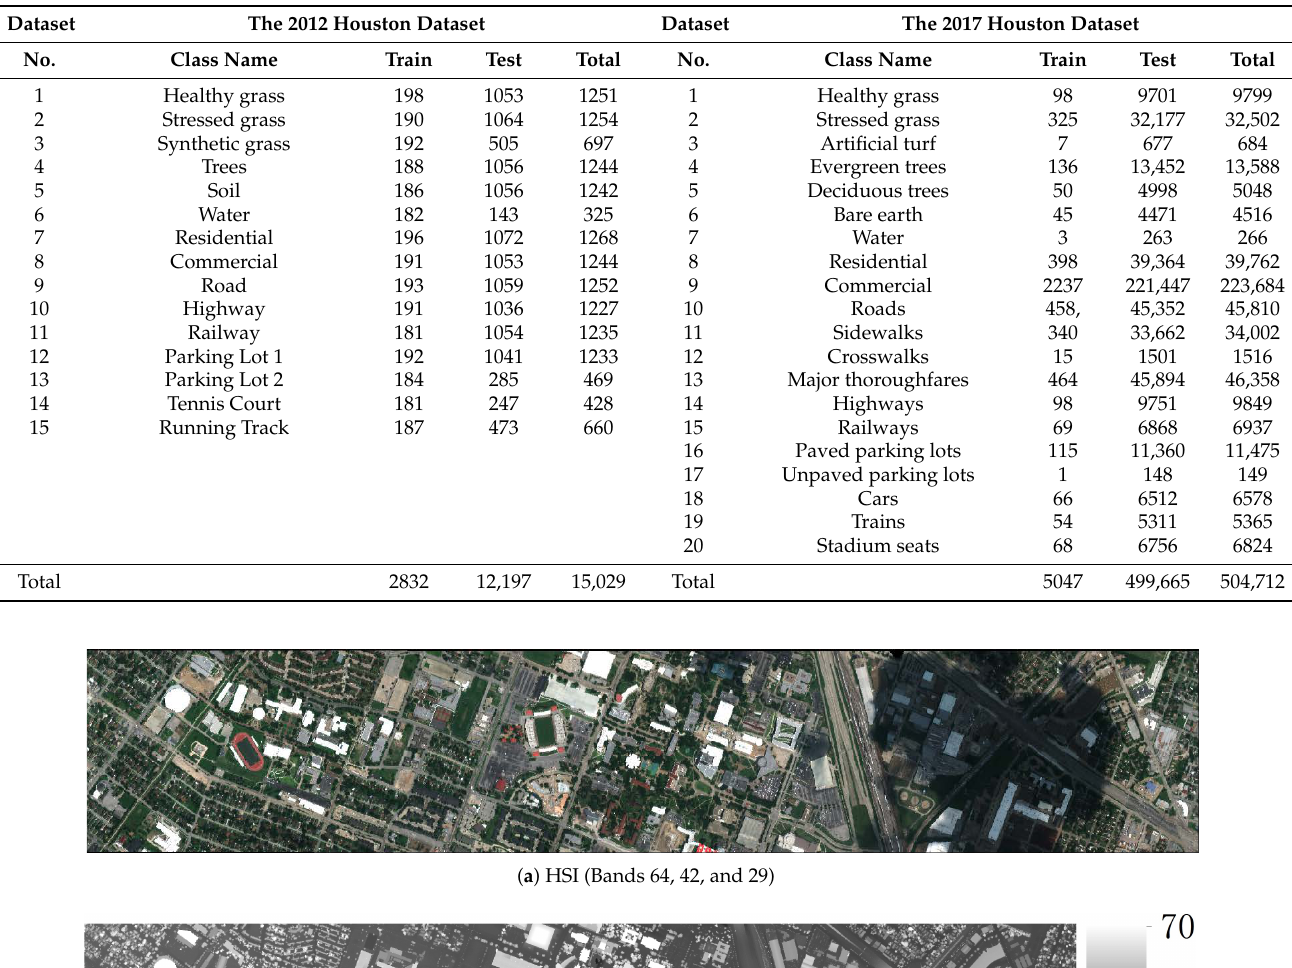
Table 1. Dataset information of 2012 Houston and the 2017 Houston. The sizes of the 2012 Houston dataset and the 2017 Houston dataset are 349 × 1905 and 1202 × 4768,